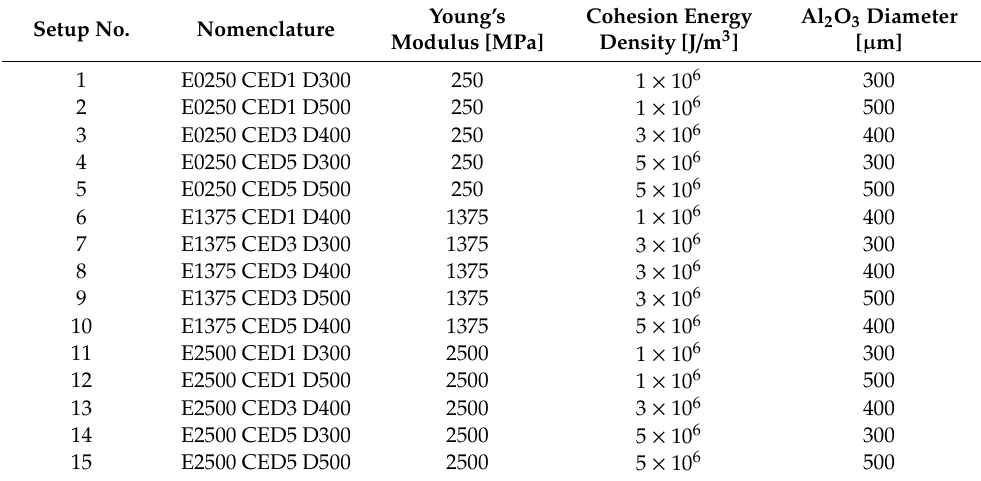
Table 3. Setups used for the preliminary analysis of the DEM models.